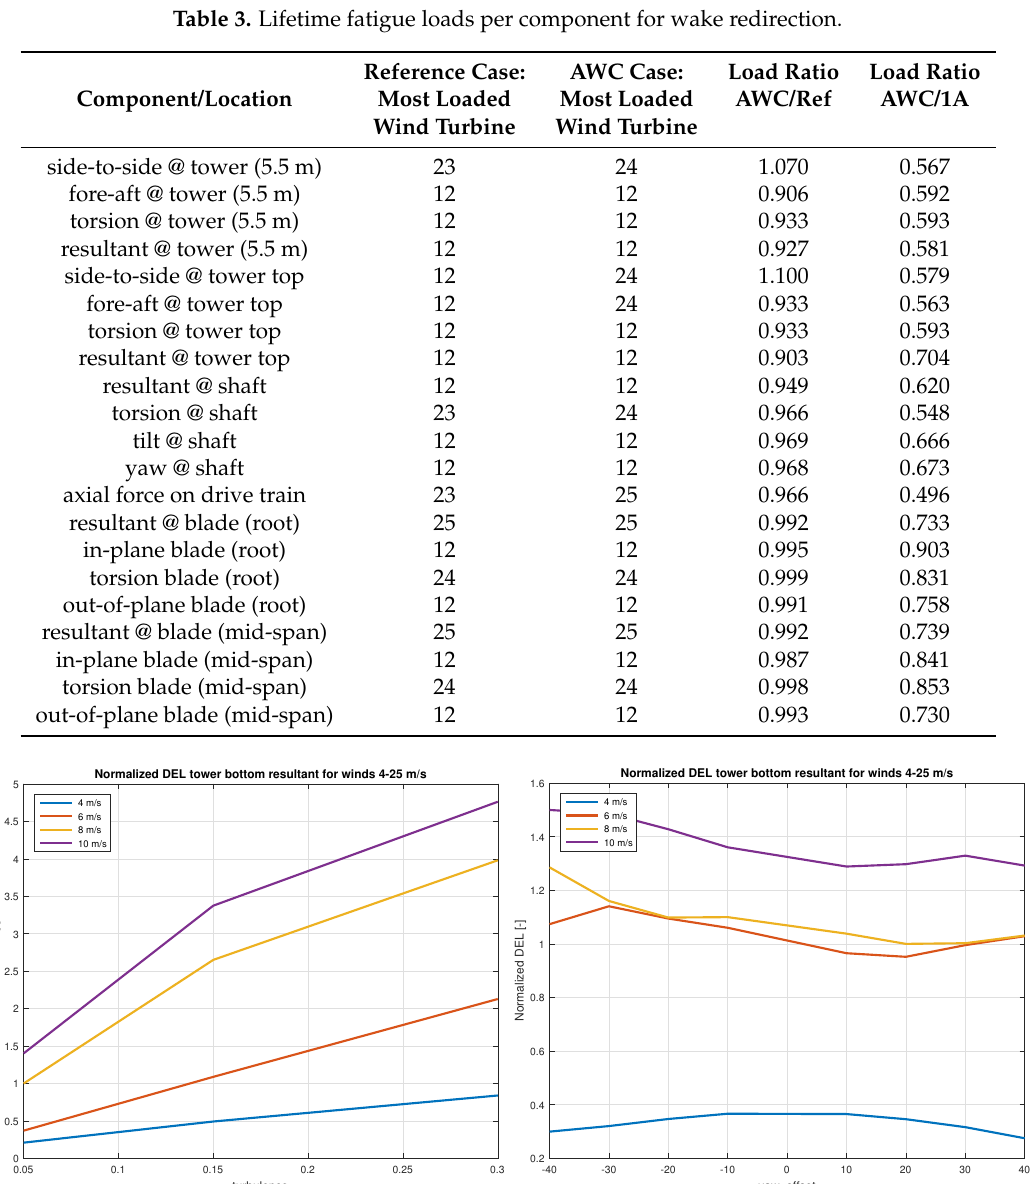
Figure 7. Sensitivities of the normalized resultant load at tower at 5.5 m with respect to the turbulence intensity at zero misalignment ( left ) and the yaw misalignment at 5% turbulence intensity ( right